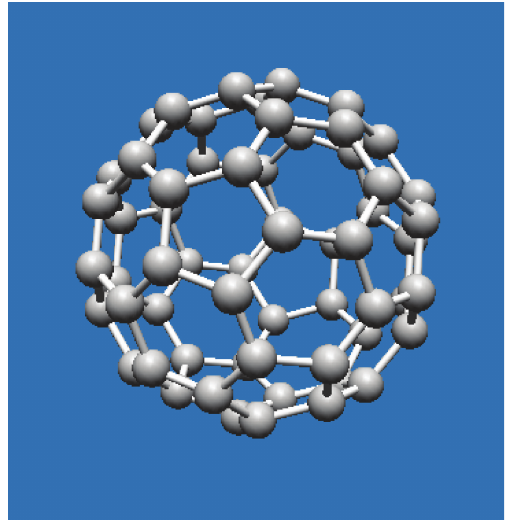
Figure 7: Schematic representation of a